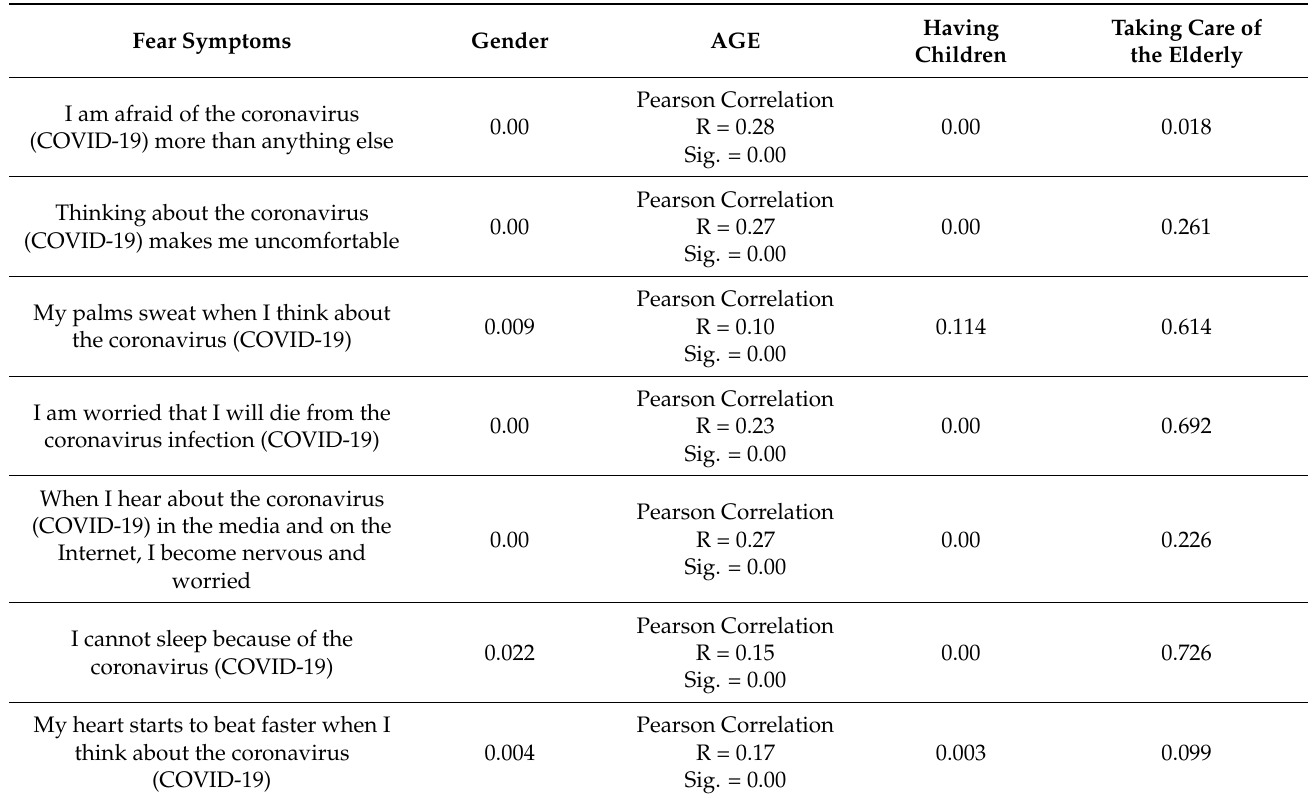
Table 4. Statistical significance of the chi-squared test and Pearson correlation coefficient